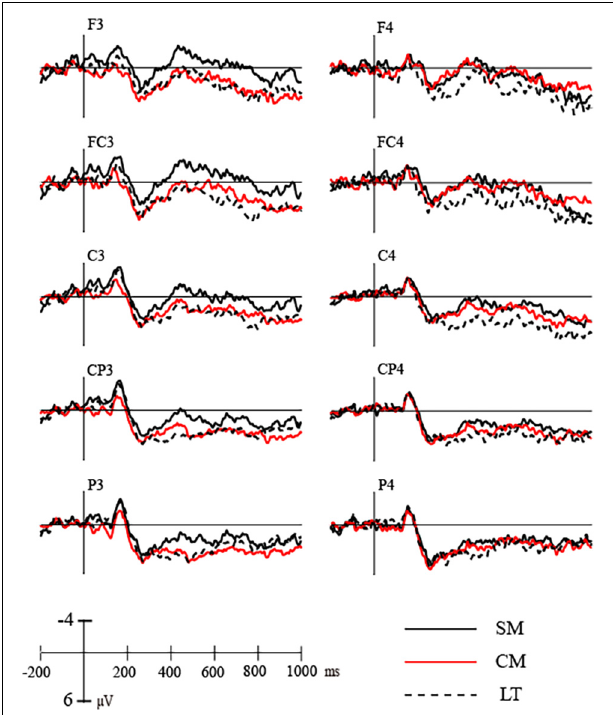
FIGURE 5 | Topographic plots of stimuli for the N400 (370–550 ms) window and the LPC (700–900 ms) window.